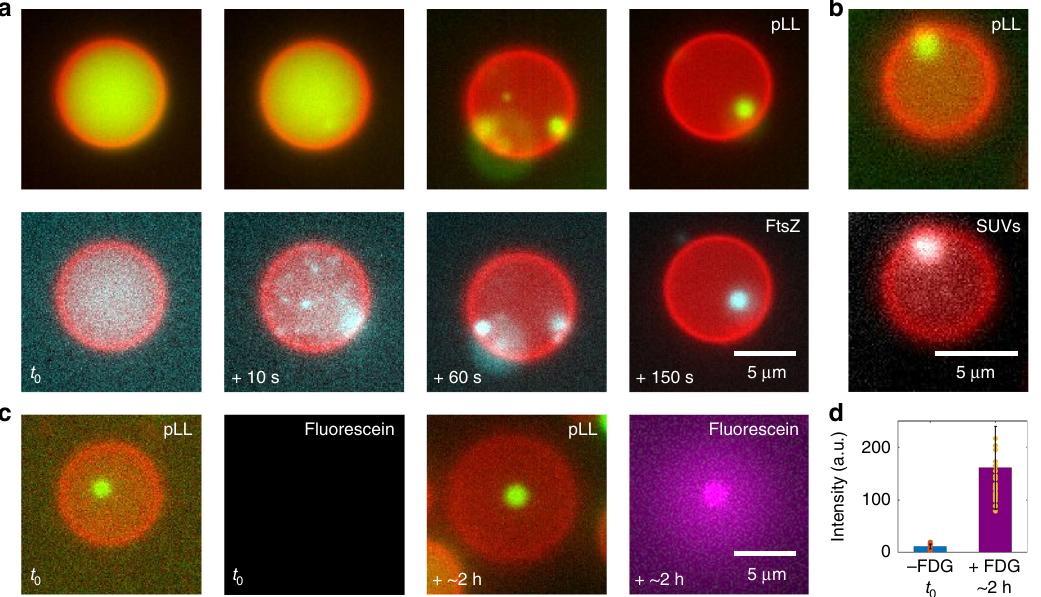
Fig. 4 Sequestration of biomolecules and compartmentalization of reactions within coacervates. The pLL/ATP coacervate (green) formed within the liposome (red) serves multiple purposes, from concentrating proteins and supramolecular assemblies to facilitating enzymatic reactions. a Fluorescence time-lapse images showing coacervation dynamics (upper panel) and simultaneous sequestration of FtsZ (cyan) within the coacervates (lower panel). b SUVs (in white) get sequestered inside the condensates. c The β -galactosidase reaction is getting carried out predominantly within the coacervate. No fl uorescent product is observed before the addition of the FDG substrate ( t — two left panels. Addition of FDG induces the enzymatic reaction inside the 0 ) liposome, particularly in the condensed phase, as can be seen from the colocalization of the fl uorescent product, fl uorescein (in magenta) with the coacervate — two right panels. d Fluorescein intensity within the coacervate phase increases about 14-fold in 2 h after the addition of the substrate ( n = 31 in both the cases). The circles represent the individual data points, bars represent the mean fl uorescence intensity, and the error bars indicate corresponding standard deviations. Source data are provided as a Source Data fi